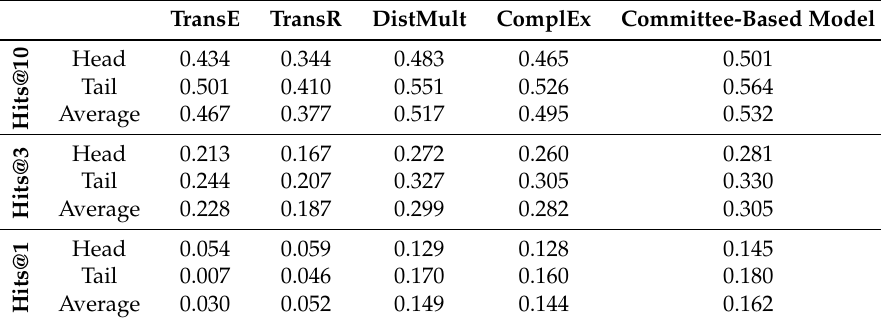
Table 6. Experimental results for FB15K data